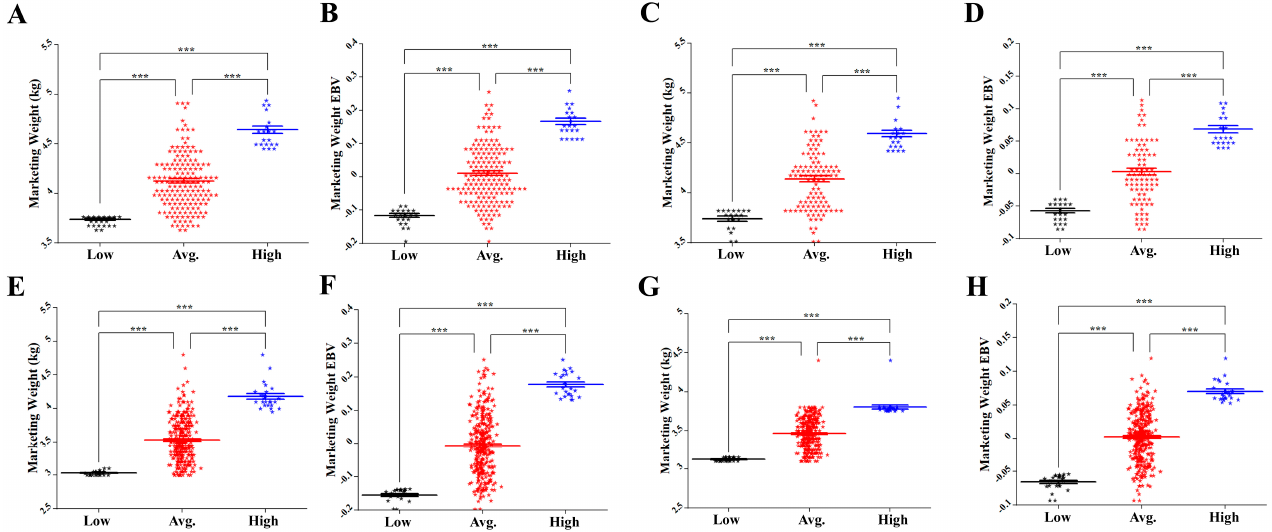
Figure 1. Average marketing weight (MW) and estimated breeding values (EBVs) for males and females from P1 and P2: ( A ) MW and ( B ) EBV of P1 males, ( C ) MW and ( D ) EBV of P2 males, ( E ) MW and ( F ) EBV of P1 females, and ( G ) MW and ( H ) EBV of P2 females between high, average, and low EBV groups. The X axis represents low, average, and high groups of males and females from P1 and P2. The Y axis represents MW (kg) or EBV. The error bars represent the standard error of mean. * p < 0.05, ** p < 0.01 and *** p <